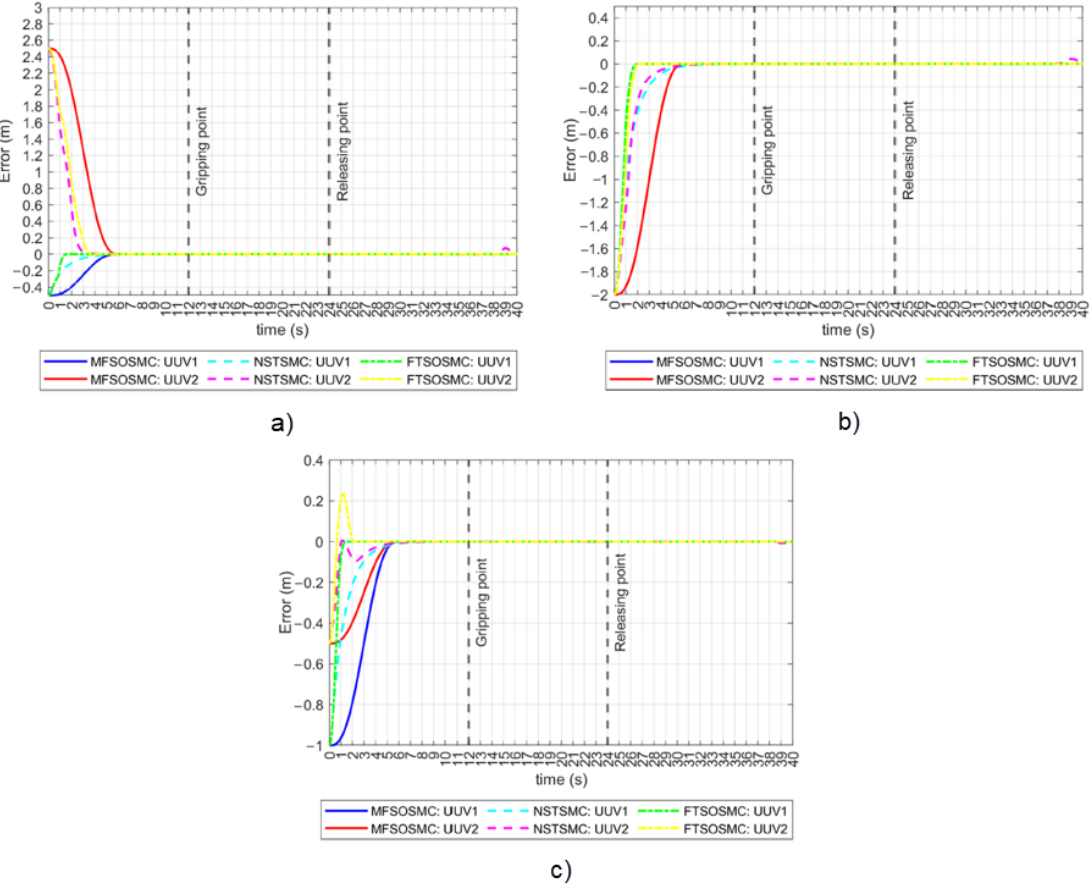
Figure 13. Tracking error for all the controllers (with external disturbances). ( a ) 𝑥 − 𝑎𝑥𝑖𝑠 . ( b ) 𝑦 − 𝑎𝑥𝑖𝑠 . ( c ) 𝑧 − 𝑎𝑥𝑖𝑠 .